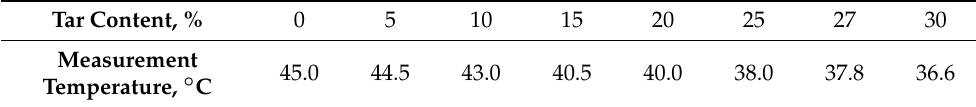
Table 7. Bitumen softening point at different tar contents.